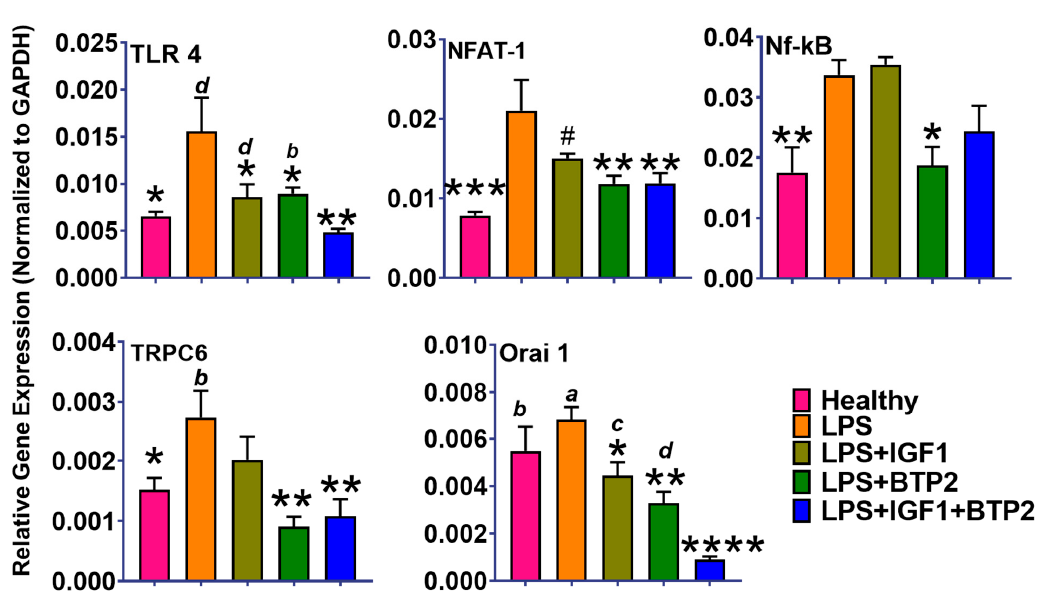
Figure 4. Favorable effects of therapies on LPS induced AKI expression of genes within the kidney related to the induction of calcium signaling. The target for BTP-2 is Orai1, which is decreased by this therapeutic agent as expected. See text for further interpretation. Data are mean ± SEM * p < 0.05, ** p < 0.01, *** p < 0.001, **** p < 0.0001, # not significant (LPS Vs. other groups), and d - p < 0.05, c - p < 0.01, b - p < 0.001, a - p < 0.0001 (LPS + IGF1 + BTP2 Vs. other groups), 1-way ANOVA followed by a Dunnett’s multiple comparisons test, ( n = 4 in each